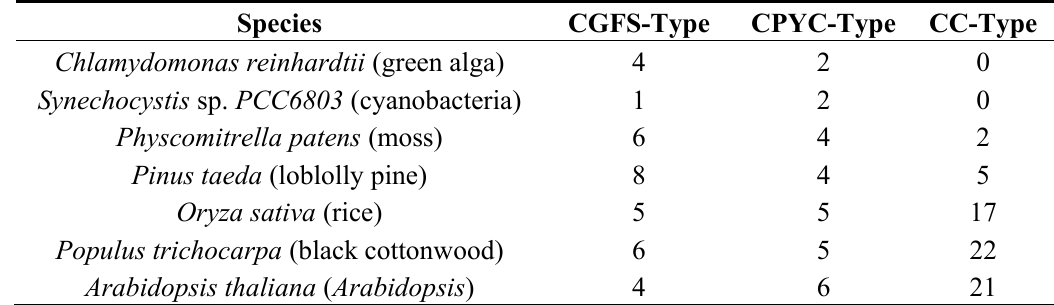
Table 1. The respective number of three GRX types in the evolutionarily representative plant